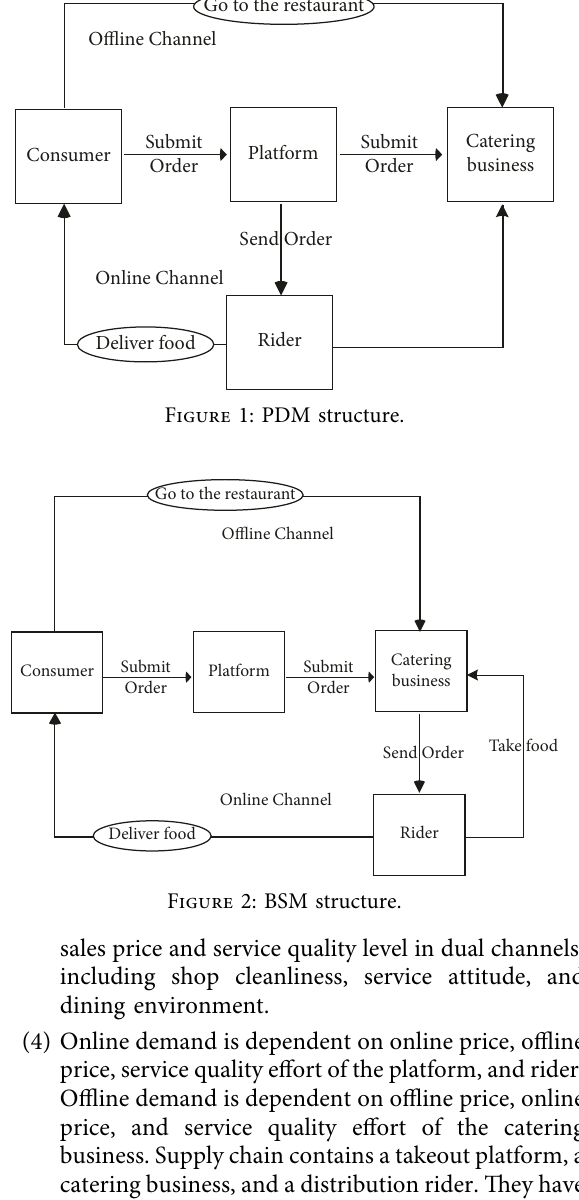
Figure 2: BSM structure.